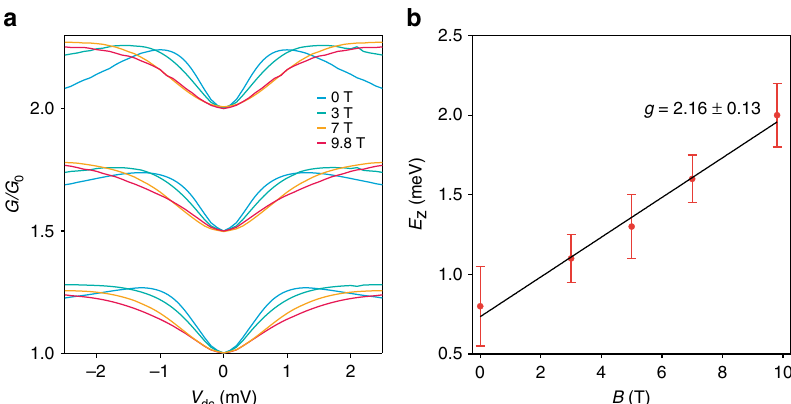
Fig. 6 Magnetic fi eld dependence and the g -factor. a Normalized curves from the maps shown on Fig. 4 in the range of 1 to 2.5 × G 0 showing the continuous increase in the Zeeman energy E z with the strength of the applied magnetic fi eld. b Linear fi t of the Zeeman energy E z as a function of the magnetic fi eld and the extraction of the Landé g -factor in the conduction band of monolayer MoS 2 . The error bars correspond to the s.e.m. of the data and were extracted from the statistical deviation of the estimated saturation values at the different conductance transition in the range 0.5 – 2 × G 0 in each map from Fig.